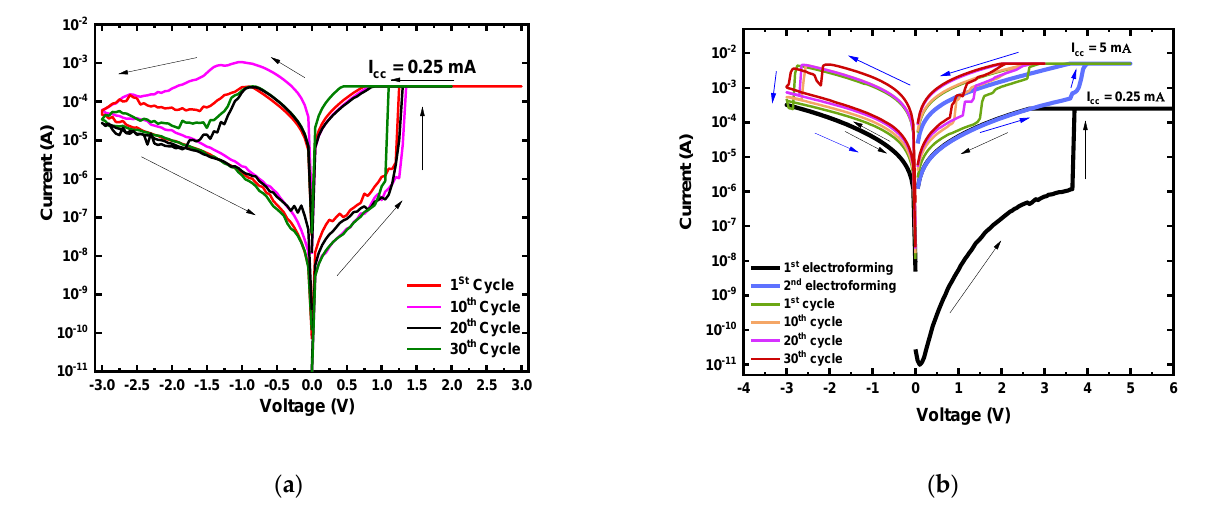
Figure 2. Typical I − V characteristics of as-deposited MgF x based Ti/MgF x /Pt memory devices. ( a ) in open − air; ( b ) in